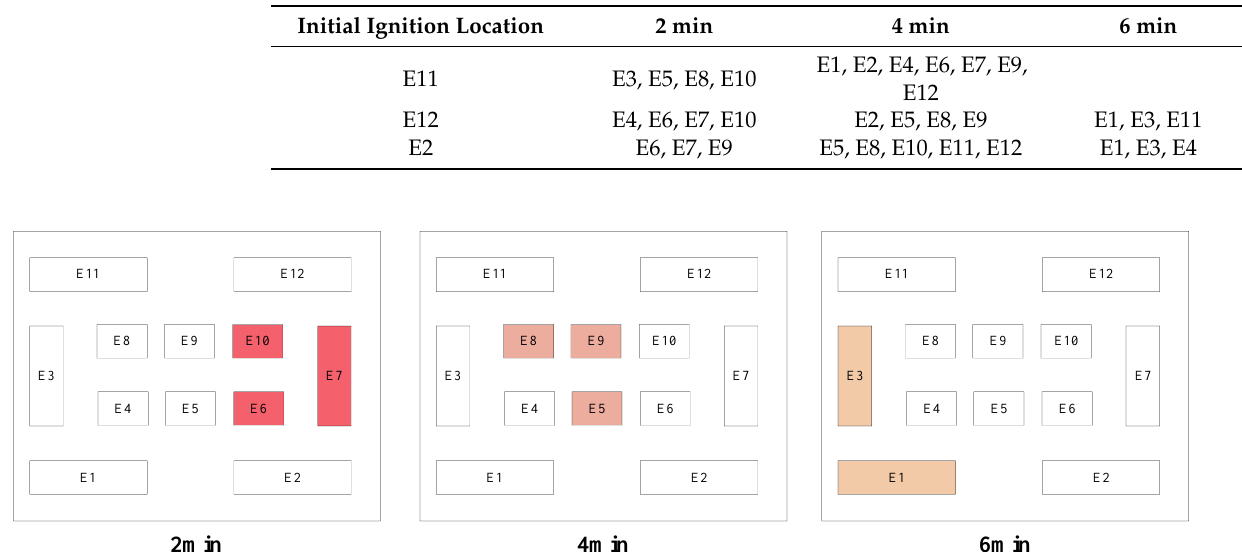
Table 9. Vital time nodes of the engine room fire's domino effect evolution.